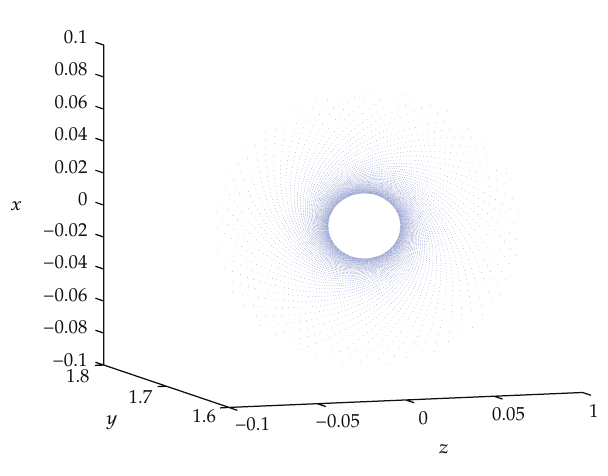
Figure 1: Phase portrait with a (cid:7) 1 . 7731